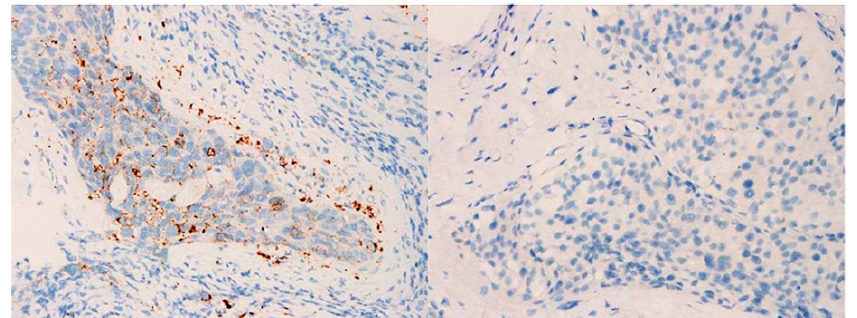
Figure 6. Representative immunohistochemistry images of programmed cell death ligand 1 in the primary samples collected from patients with urothelial carcinoma. Magnification: 400×. Left : im-